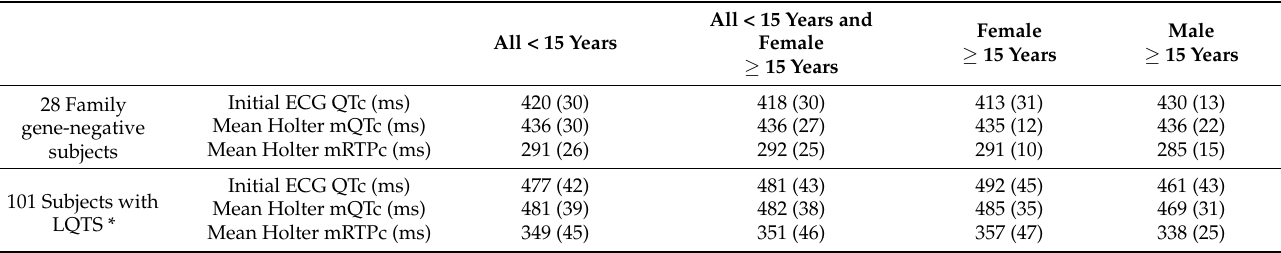
Table 1. Initial 12 lead ECG QTc and Holter mQTc and mRTPc values for LQTS subjects and gene negative relatives (Mean (SD)).